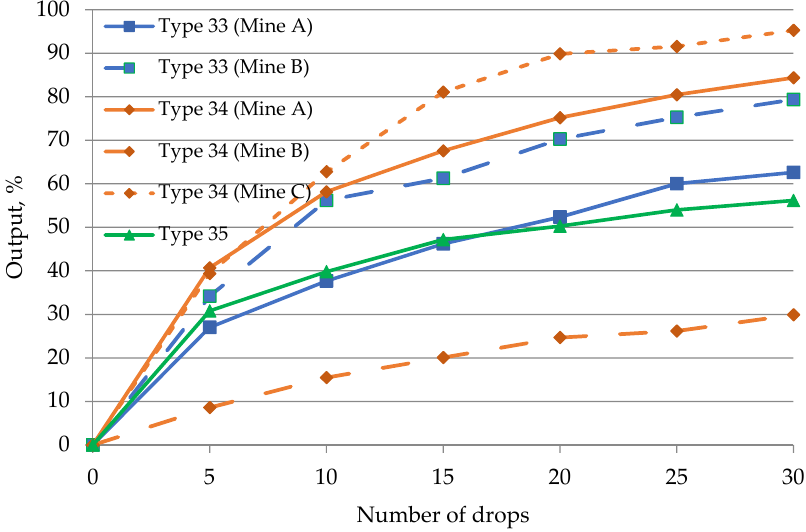
Figure 8. Comparative results of testing the susceptibility to crushing for the 33, 34, and 35 coal types—stone grains (waste rock) [43].